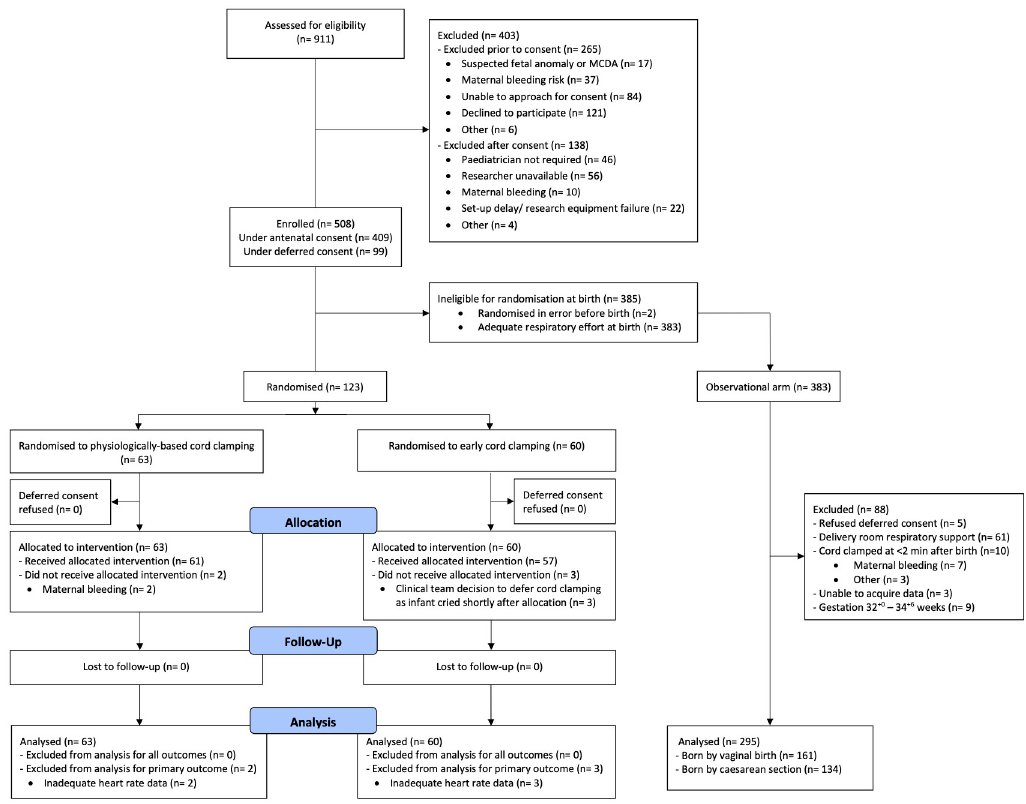
Fig 1. Modified CONSORT diagram showing participant recruitment and allocation in the randomised trial and observational arms of the study. MCDA, monochorionic diamniotic.